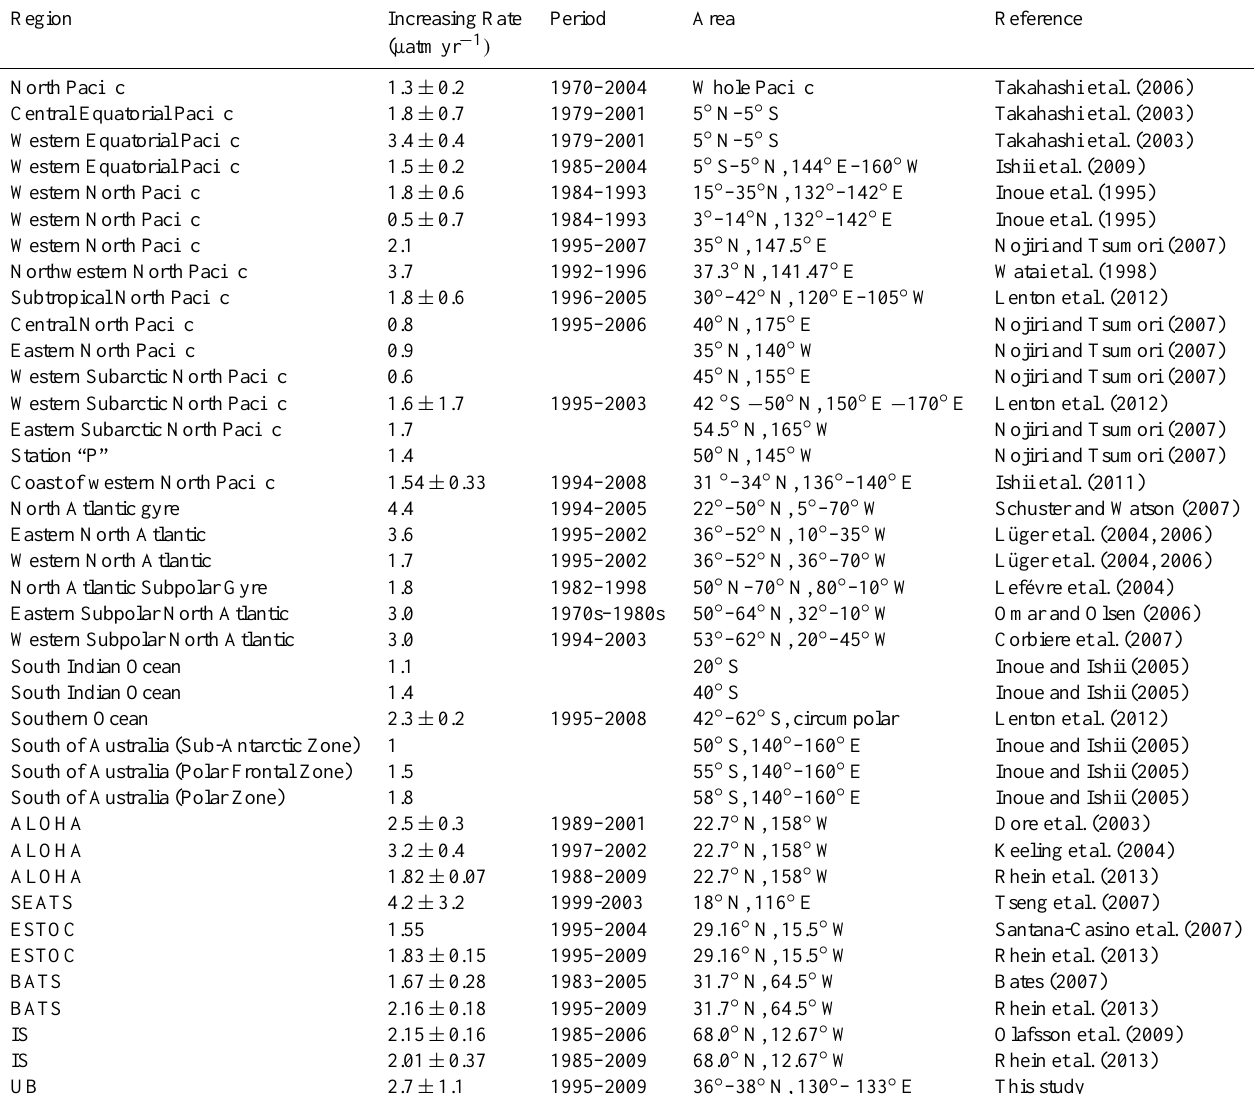
Table 3. Rate of increase of surface seawater CO 2 at various regions of the world ocean.